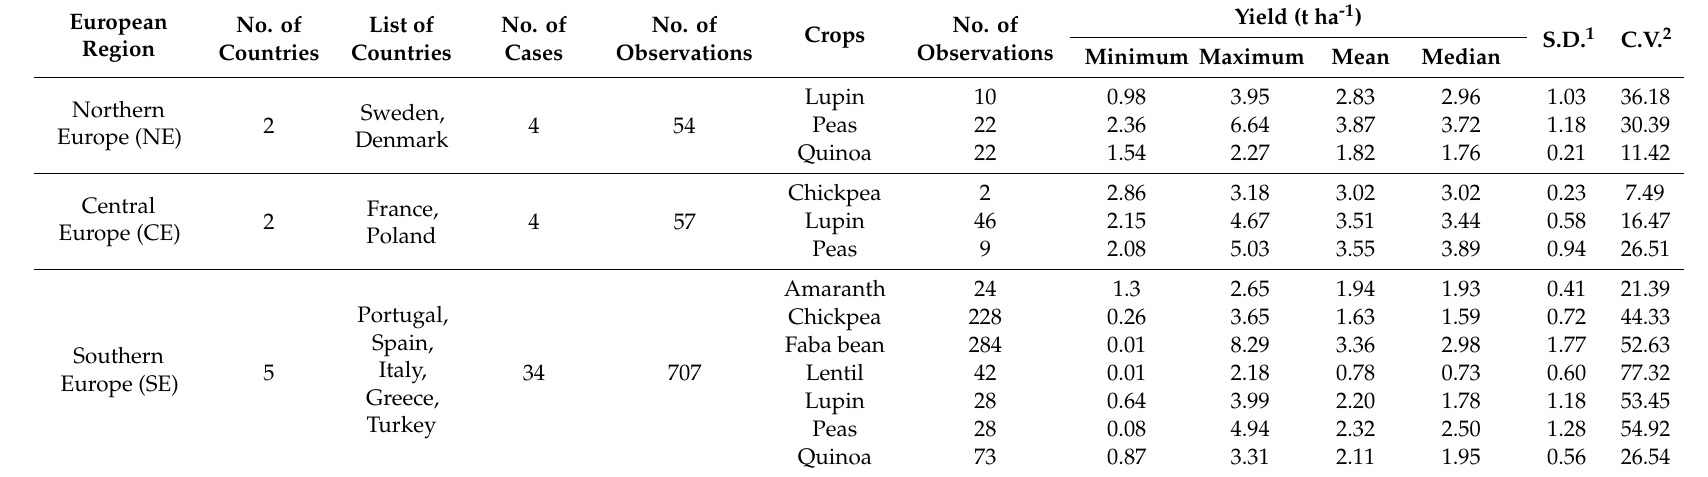
Table 2. Descriptive statistical parameters (minimum, maximum, mean, median, SD and CV) relative to yield (t ha − 1 ) for all crops and split into northern (NE), central (CE), and southern (SE)